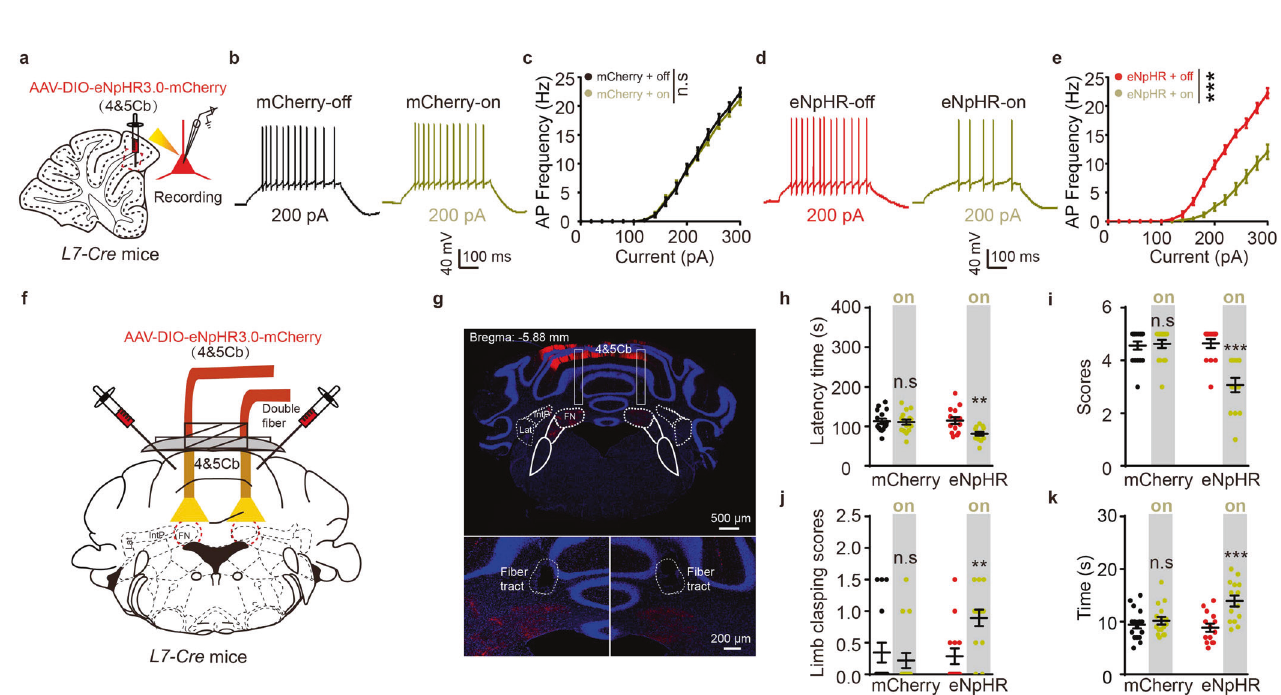
Fig. 2 Optogenetic inhibition the circuit from IV/V lobe to FN induces ataxia-like behavior. a L7-Cre mice were injected with AAV-DIO- eNpHR3.0-mCherry or AAV-DIO-mCherry in IV/V lobe, and whole-cell recordings were performed in mCherry + neurons. b – e Representative ( b , d ) and Quanti fi cation ( c , e ) of action potential (AP) traces in mCherry + neurons in brain slices of IV/V lobe under 589-nm yellow light on or off ( n = 17 cells from mCherry-injected mice; n = 14 cells from eNpHR-injected mice; *** P < 0.001; two-way ANOVA followed by Turkey ’ s multiple comparisons test). f Schematic of AAV-DIO-eNpHR3.0-mCherry or AAV-DIO-mCherry injection into the IV/V lobe and optical cannula implantation in the bilateral FN. g Representative injection site in IV/V lobe and optical fi ber placement for optogenetic experiments. h – k The ataxia-related behaviors were performed ( n = 16, 14 mice per group; ** P < 0.01; *** P < 0.001; one-way ANOVA followed by Turkey ’ s multiple comparisons test). Quanti fi cation of the time spent on the accelerating rotarod ( h ), Quanti fi cation of the scores during runs on an elevated horizontal beam ( i ). Quanti fi cation of the limb clasping scores when suspended by the tail ( j ), Quanti fi cation of time spent on the pole ( k ). Error bars represent means ± s.e.m; ns not signi fi